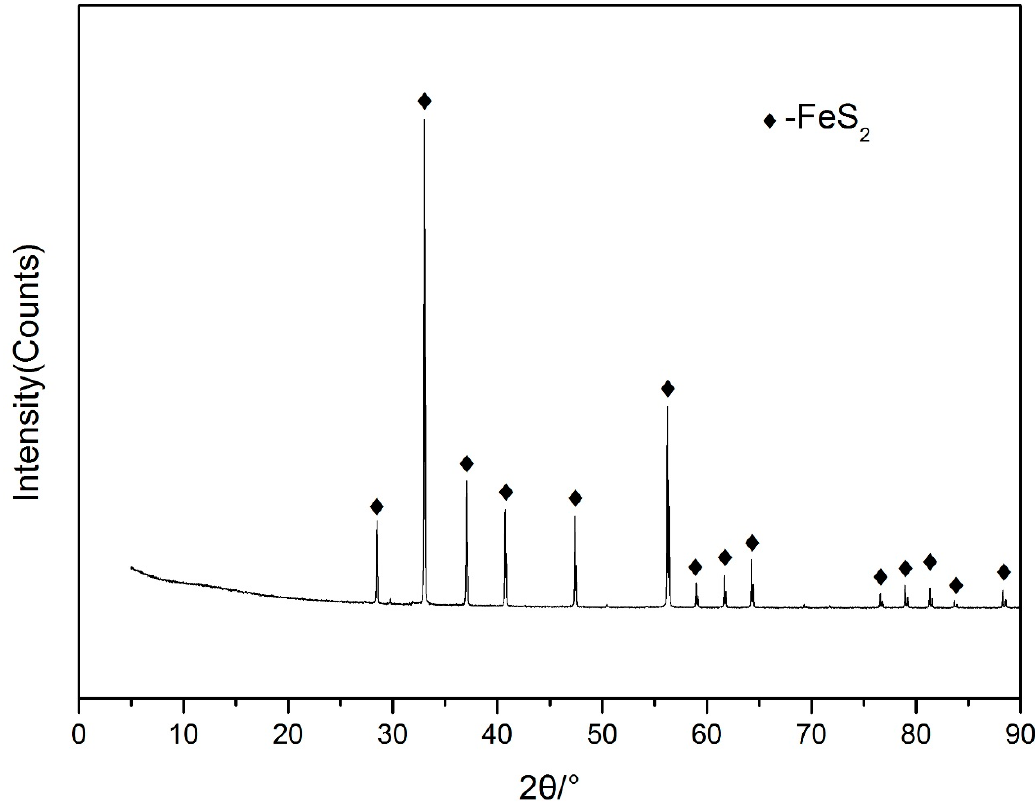
Figure 2. XRD spectra of pyrite sample.